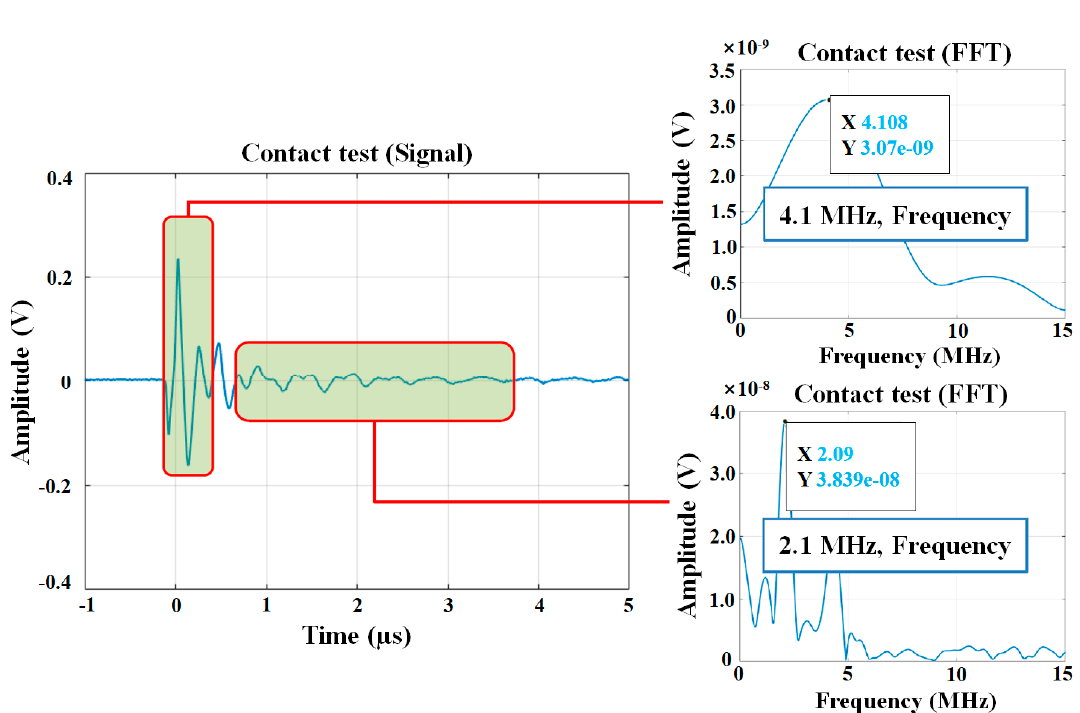
Figure 5. Calibration of the ultrasonic device for coating thickness measurement.